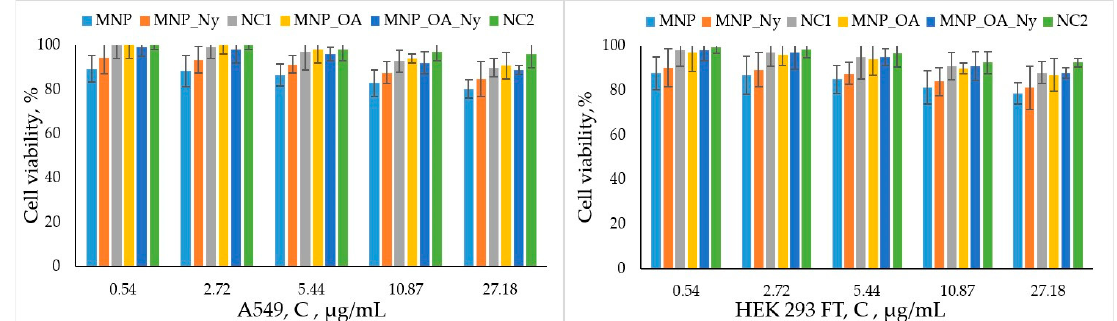
Figure 7. Cell viability assay. Cell lines A549 and HEK 293FT were incubated for 48 h with MNCs and NCs. Cells treated with PBS bu ff er were used as a 100% viability control. All values are given as mean ± standard deviation (SD) values. All measurements were repeated no fewer than three times.